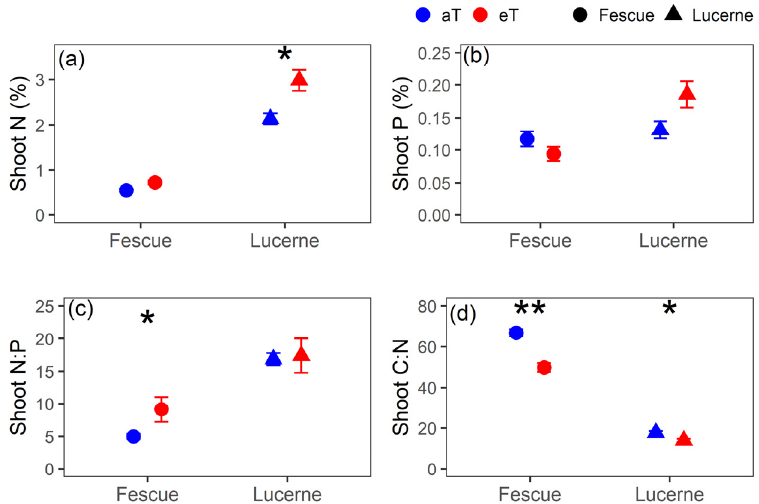
Figure 6. Shoot nutrient stoichiometry ( a ), Shoot N ( b ) P ( c ) N:P ratio ( d ) C:N ratio for tall fescue (circles) and lucerne (triangles) grown under 26 ◦ C (aT, blue) and 30 ◦ C (eT, red). Error bars indicate ± standard error. Statistically significant differences between temperature treatments are portrayed as * ( p < 0.05), ** ( p < 0.01).